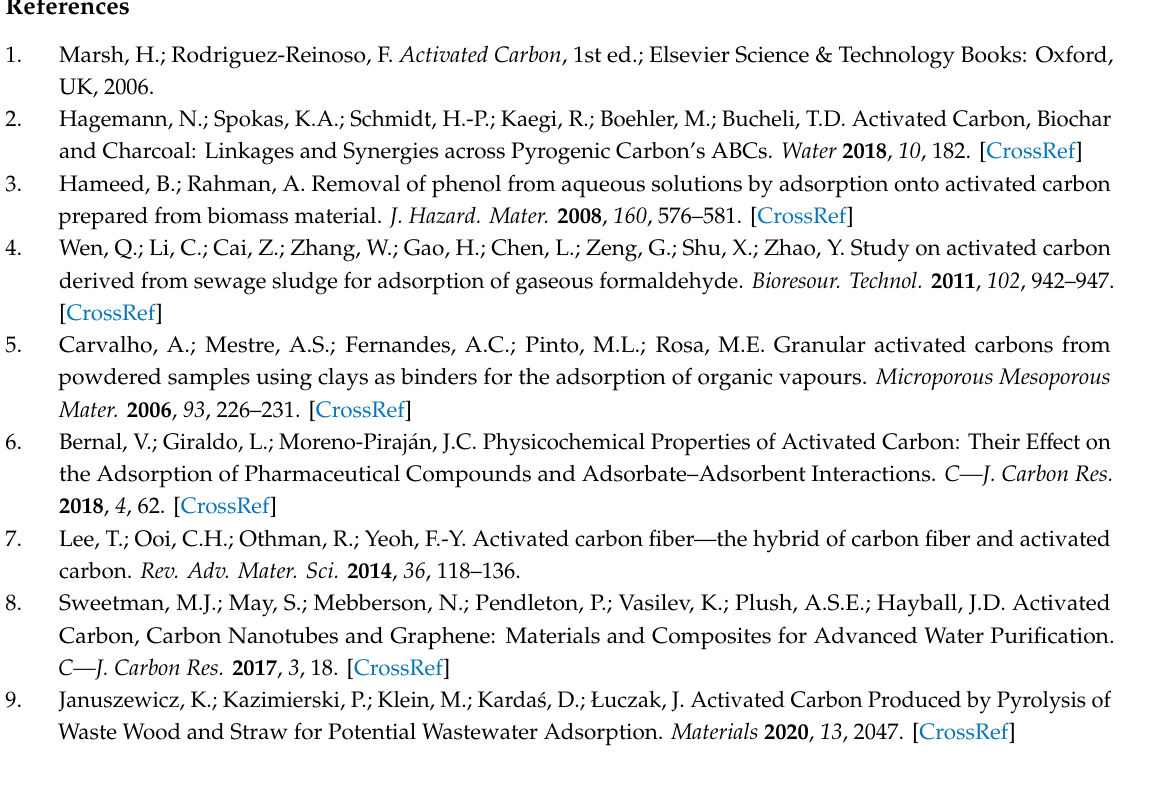
Figure S1: Stone mill for hard coal grinding, Figure S2: Coal and binder paste, Figure S3: Granulator output, Figure S4: Activation furnace, Table S1: Analytical methods and procedures used for individual active coal’s indicators